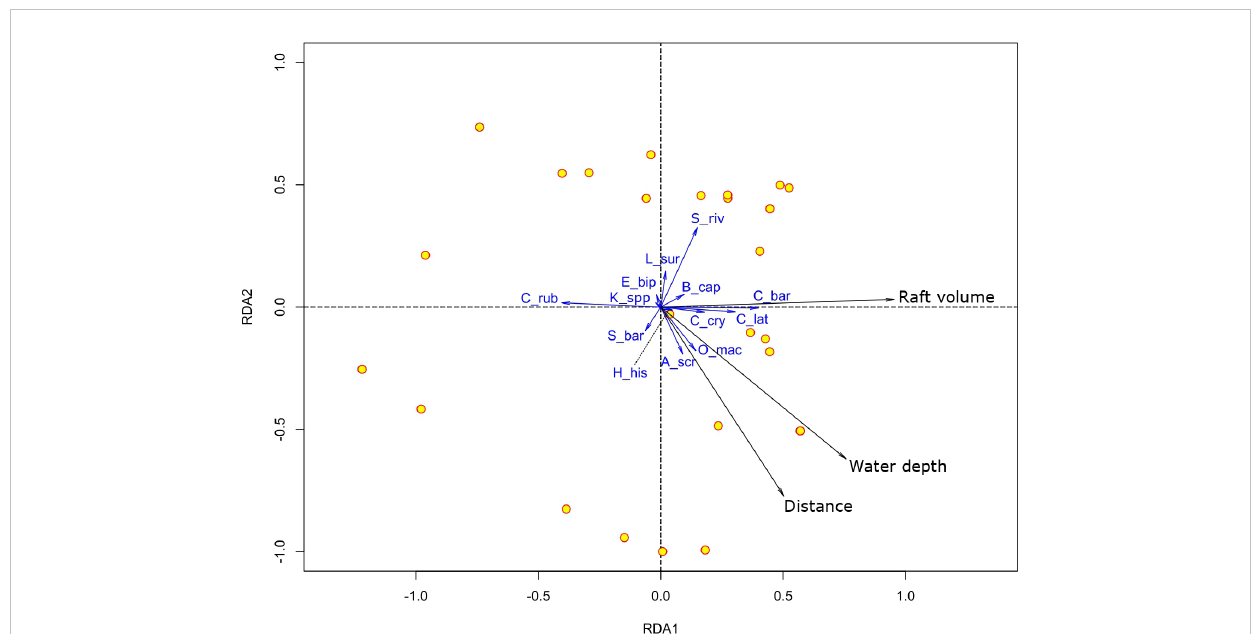
FIGURE 4 Redundancy analysis (RDA) ordination plot showing the effect of distance, water depth and raft volume on species composition of the free-swimming fauna associated with pelagic sargassum. S. rivoliana (S_riv), B. capriscus (B_cap), C. bartholomaei (C_bar), L. surinamensis (L_sur), C. latus (C_lat), C. crysos (C_cry), C. ruber (C_rub), E. bipinnulata (E_bip), Kyphosus spp. (K_spp), S. barracuda (S_bar), H. histrio (H_his), A. scriptus (A_scr), O. maculata